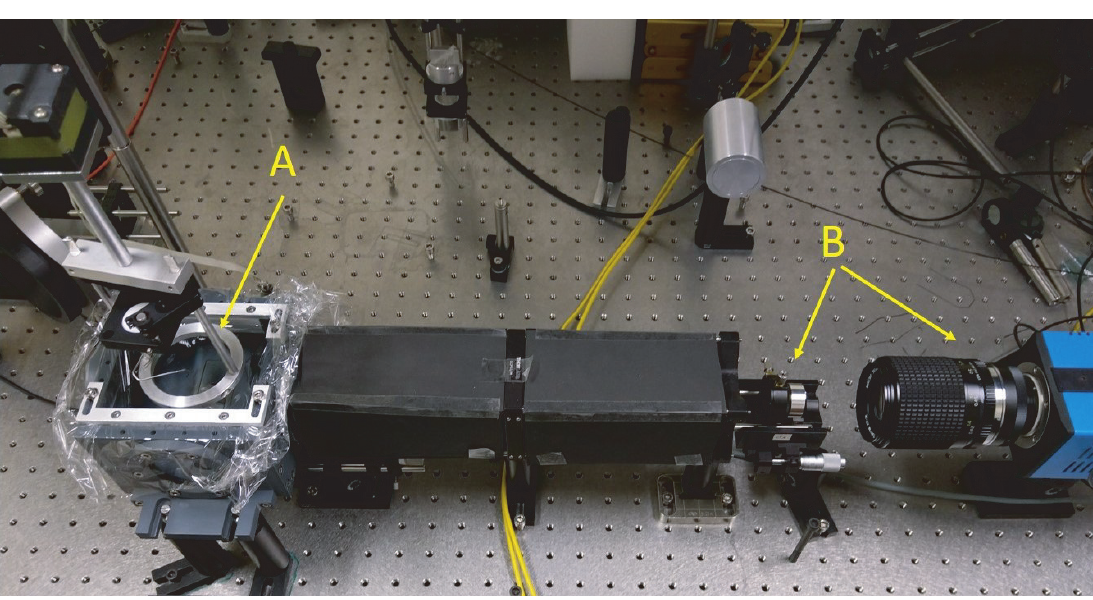
Figure 1. FFD-PAT SETUP DEVELOPED IN G RAZ . The sample to be imaged is mounted and rotated on stage A. Full field projections of p ( · , T ) are recorded with the CCD camera B using an optical phase contrast technique. For a detailed description of the working principle, see the original works